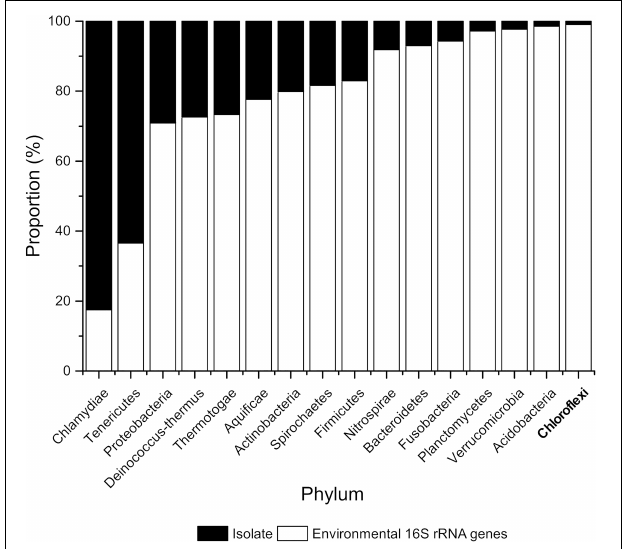
FIGURE 1 | Proportion (%) of isolates and environmental 16S rRNA sequences belonging to selected bacterial phyla based on 16S rRNA sequences. Numbers of 16S rRNA sequences were extracted from the Ribosomal Database Project version 11, updated in September 2016 (Cole et al.,